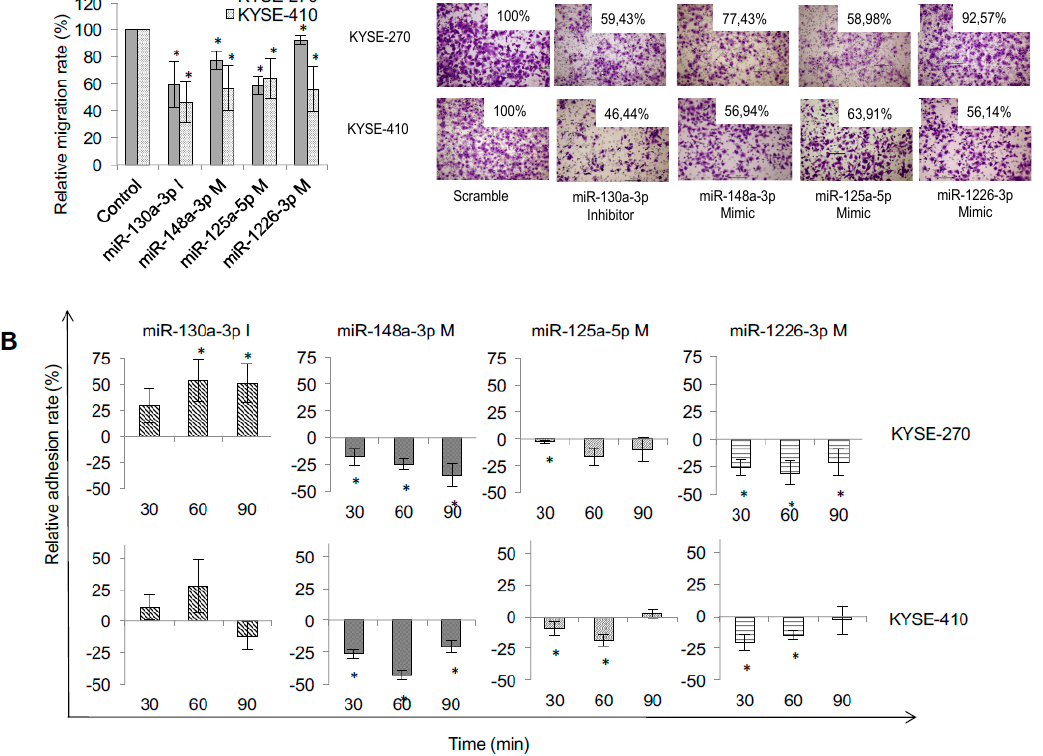
Figure 3. Specific miRNA signatures of resistant cell lines impact on metastatic behavior of ESCC. ( A ) Migration assay of transfected cells (200 × magnification). K270: KYSE-270, K410: KYSE-410, M: Mimic, Inhib. +I: inhibitor; * significant difference ( p ≤ 0.05); ( B ) effect of adhesion assay after transfection. M: mimic, I: inhibitor; * significance ( p ≤ 0.05).